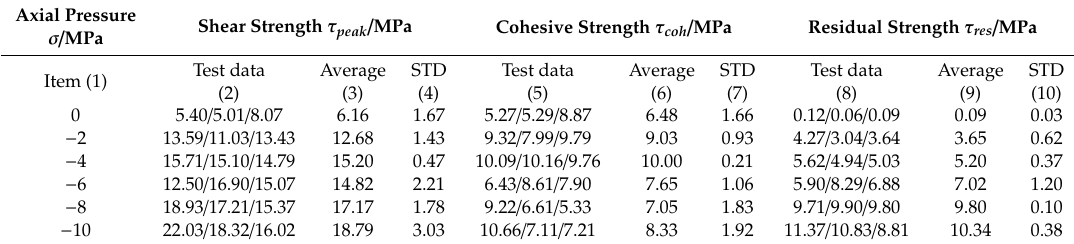
Table 4. SCC compression-shear test results under di ff erent axial stress.